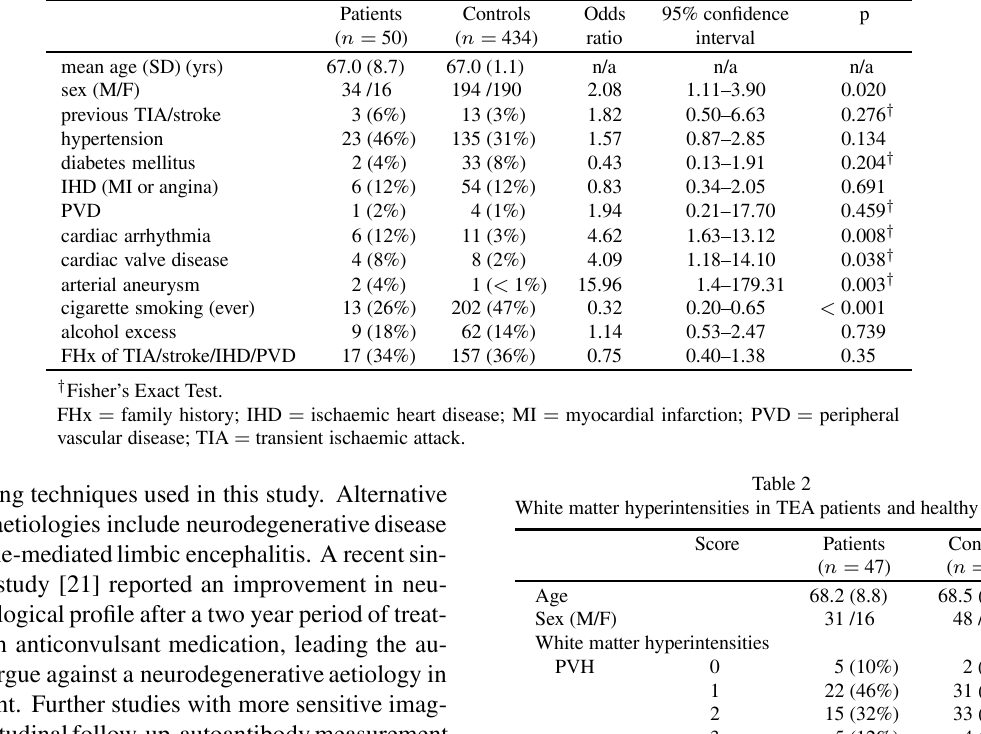
Table 1 Cerebrovascular disease risk factors in TEA patients and LBC1936 healthy control subjects Patients Controls